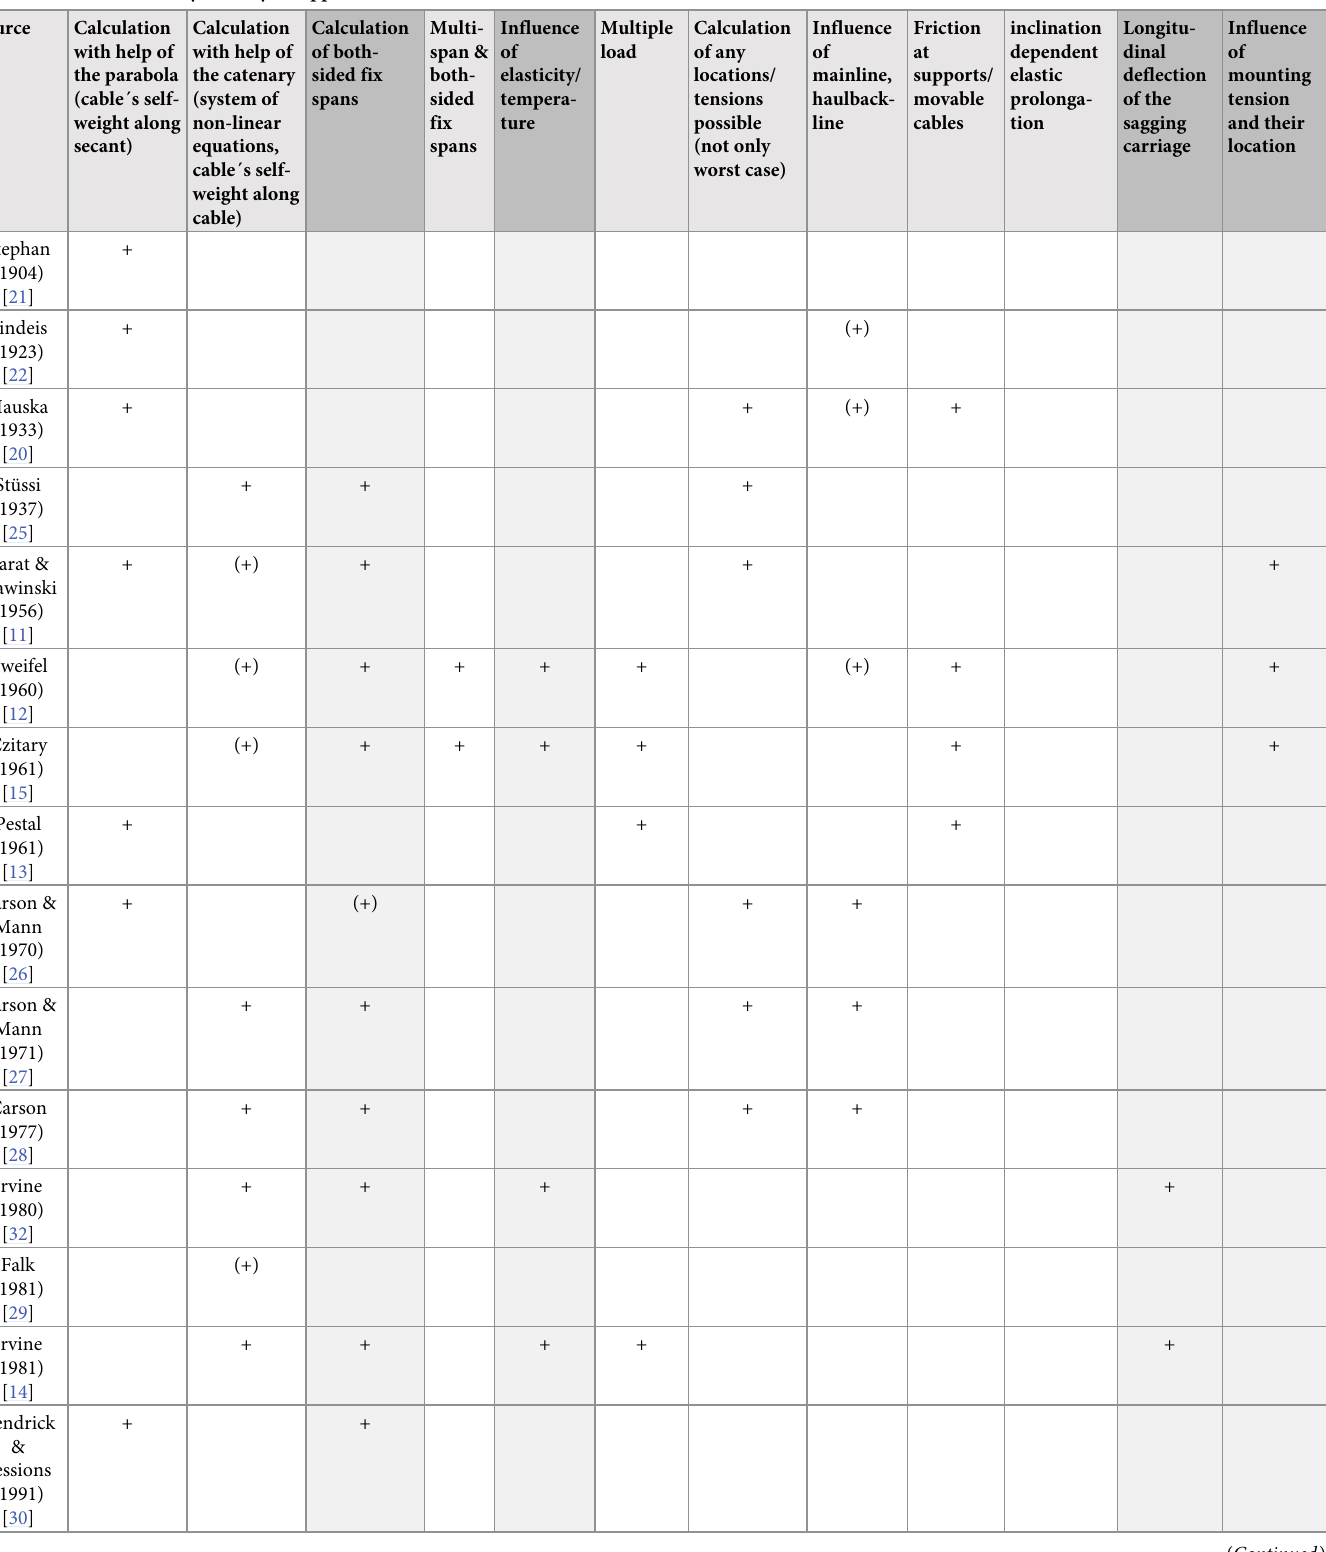
Table 1. Tabular summary of analysed